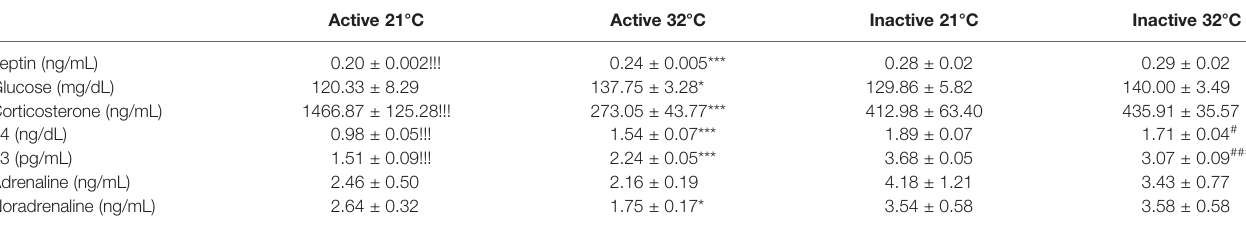
TABLE 1 | Serum parameters in the experimental groups.